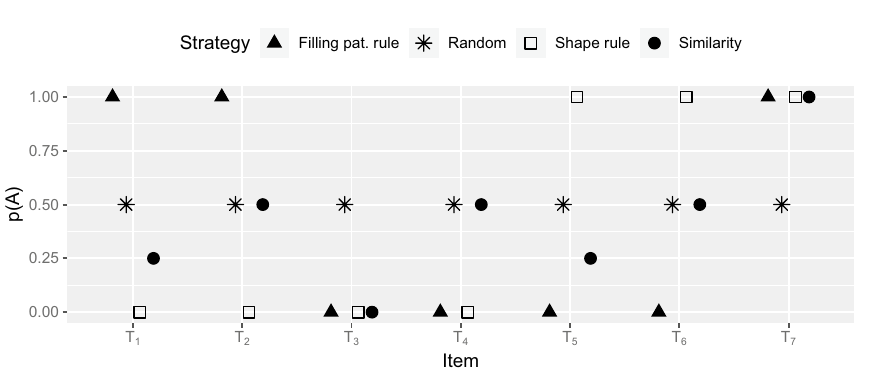
0.000.250.500.751.00